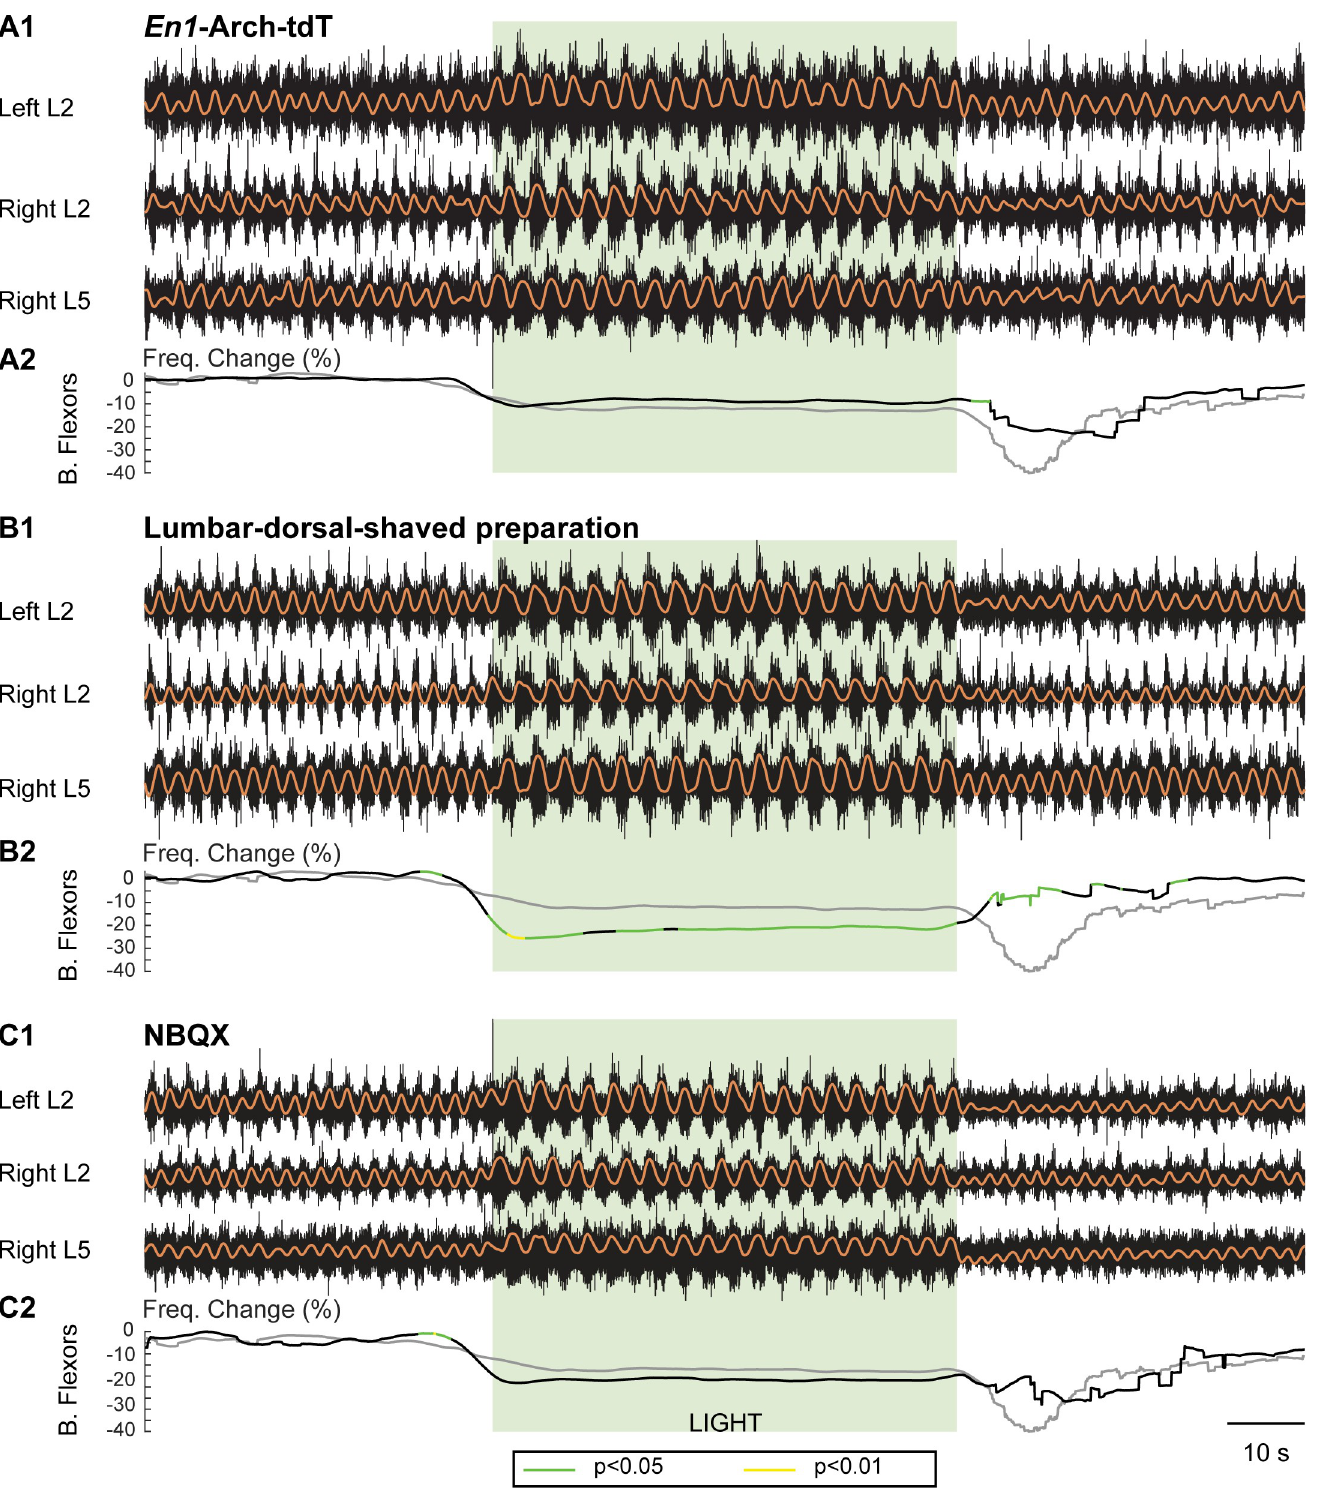
Fig 7. The light-induced decrease in frequency in En1 -Arch cords is due to a ventral, nonglutamatergic mechanism and is similar in En1 -Arch and En1 -Arch- tdT spinal cords. (A1) Locomotor-like activity evoked by 5 μ M NMDA, 10 μ M 5-HT, and 50 μ M DA in an En1 -Arch-tdT spinal cord. The black traces show the high-pass (10 Hz) filtered signal from the left and right L2 and the right L5 ventral roots. The superimposed orange traces are the integrated neurograms. (A2) Time series showing the change in frequency averaged for all experiments for the bilateral flexor roots from En1 -Arch-tdT preparations (black lines) and En1- Arch